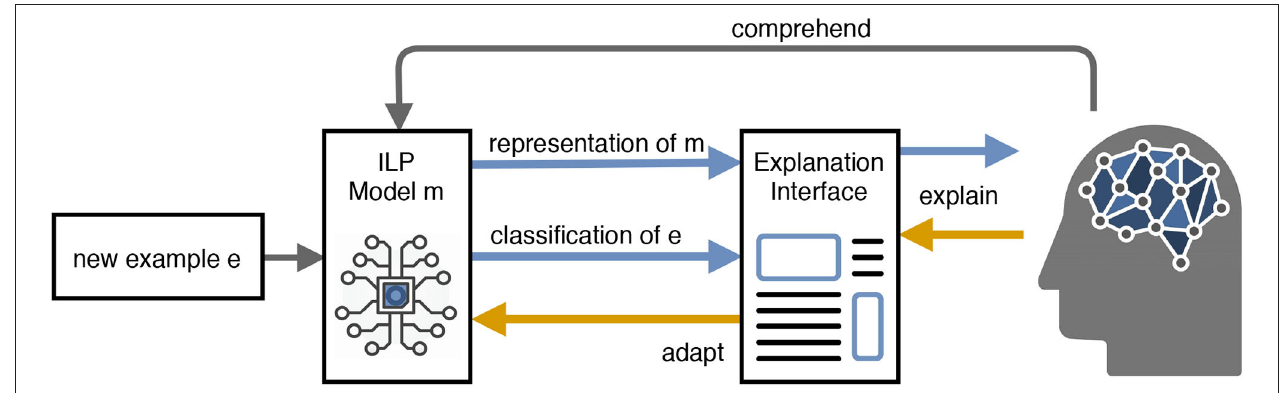
FIGURE 9 | Model of a mutual explanations system (Schmid and Finzel,